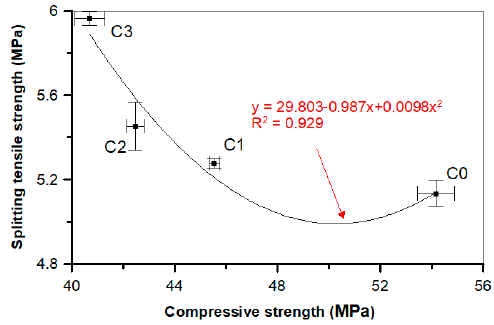
Figure 19. Relationship between the compressive and splitting tensile strengths of a concrete.